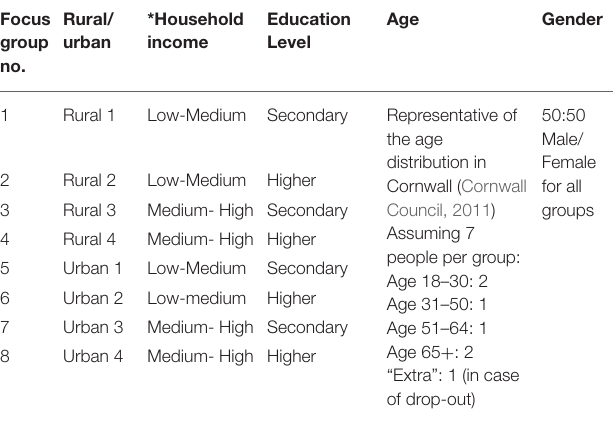
TABLE 2 | Purposive sampling matrix used to guide focus group recruitment. Focus